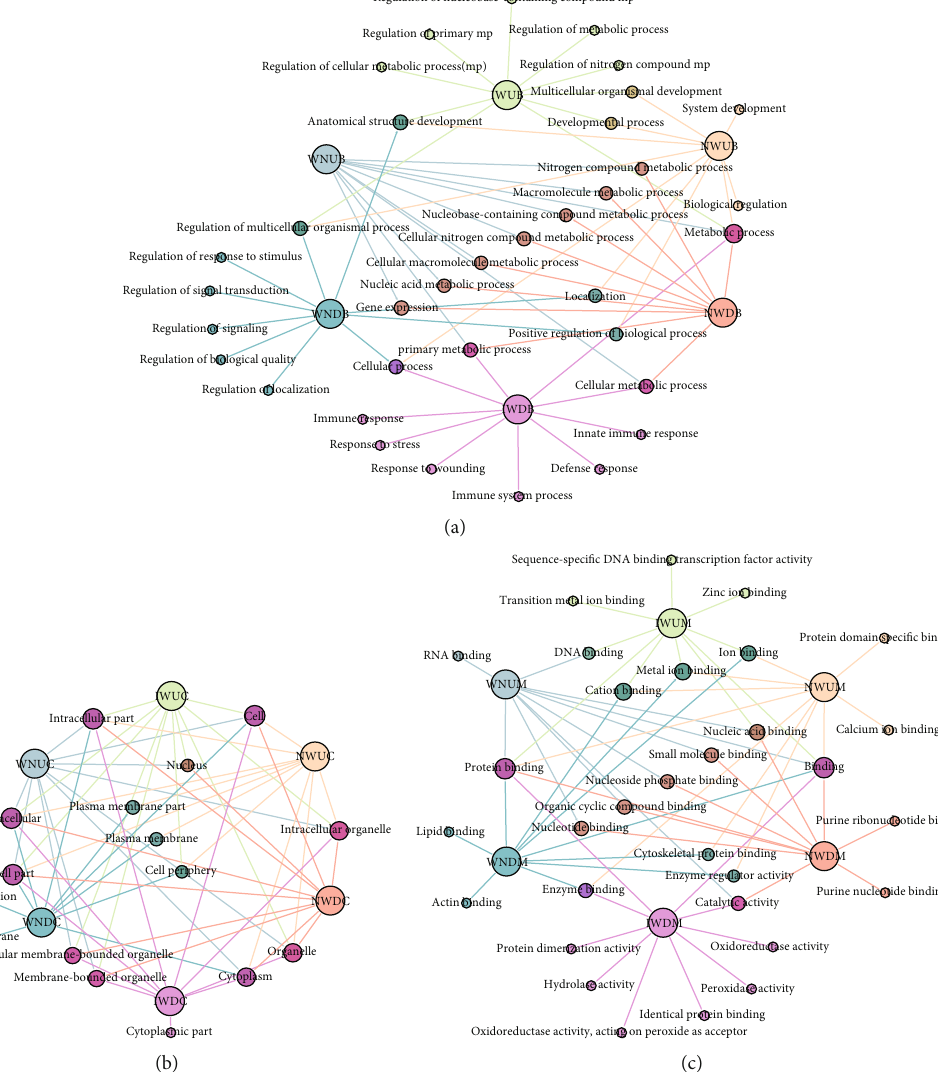
Figure 6: Relationship networks of DE genes between before and after M. tuberculosis infection and INH or NBXH-H treatment. The BP (a), CC (b), or MF (c) relationship networks among the normal control, Water, INH, and NBXH-H groups were conducted by Gephi software. WNUB, IWUB, NWUB or WNDB, IWDB, NWDB represented up- or downregulated DE genes involved in BP among the four groups. WNUC, IWUC, NWUC or WNDC, IWDC, NWDC represented up- or downregulated DE genes involved in CC among the four groups. WNUM, IWUM, NWUM or WNDM, IWDM, NWDM represented up- or downregulated DE genes involved in MF among the four groups. Relationships of interest are shown in bold